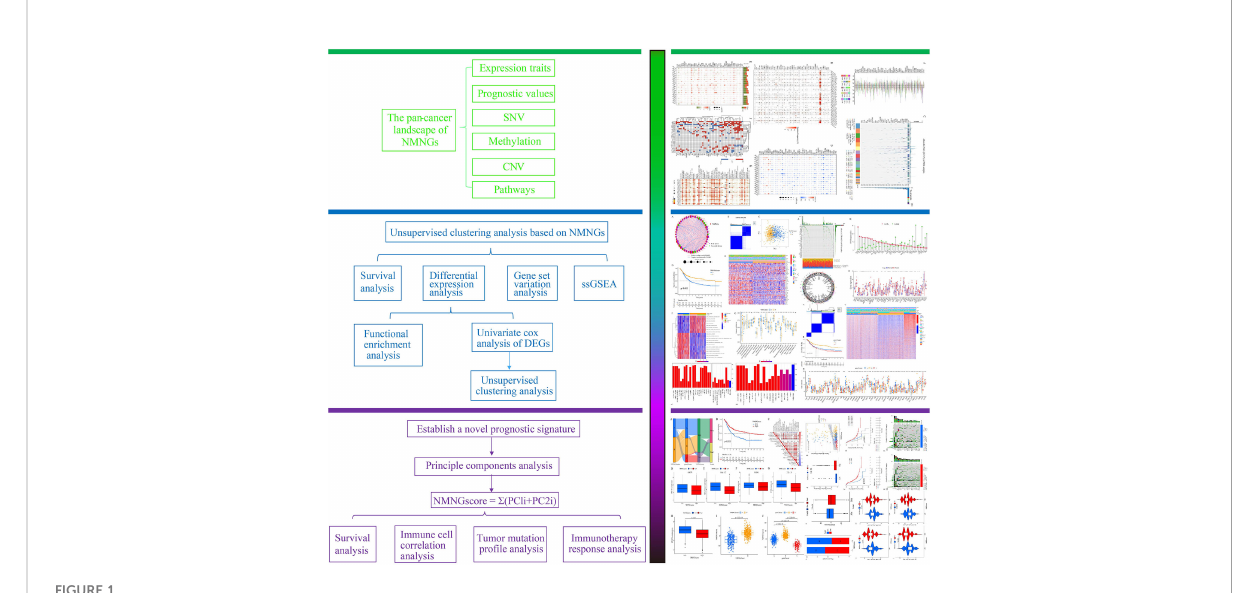
FIGURE 1 The investigation ’ s fl ow